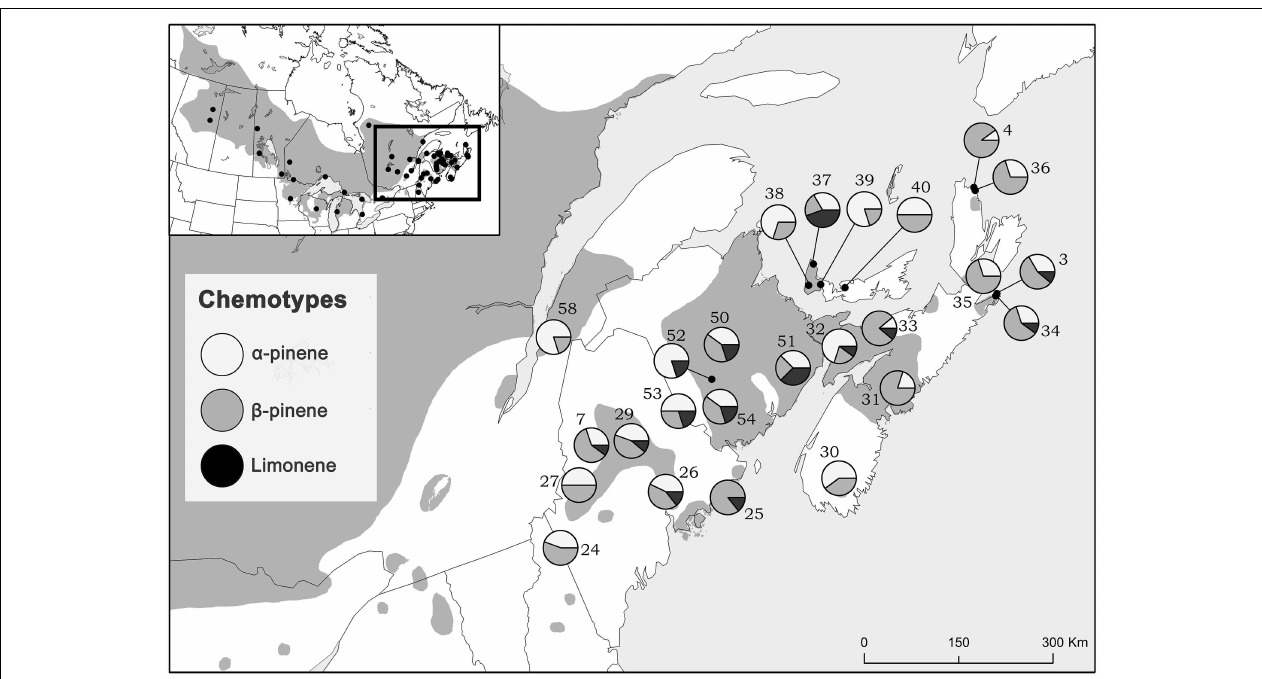
FIGURE 3 | Jack pine ( Pinus banksiana) natural stand locations in eastern Canada and northeastern US colored proportionately by chemotype frequency. Numbers represent site designations and shaded area of map represents jack pine’s range.